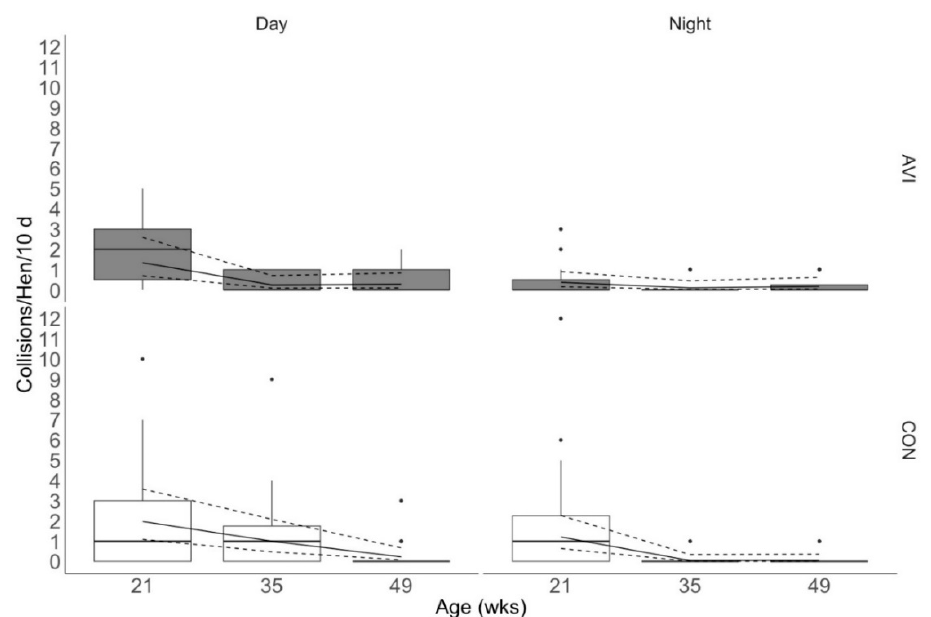
Figure 3. Total collisions >20 G sustained per hen over 10 d at each age during lights on (16 h/d) and lights off (8 h/day) in enriched colony cages (ECC). Hens were reared in either conventional non-enriched cages (CON) or a multi-tiered aviary (AVI) until 19 weeks of age before being moved into ECC. Collisions were with structural objects or conspecifics. Boxes represent the interquartile range, where the black line represents the median, the top of the box represents the 75th quartile, and the bottom of the box represents the 25th quartile. Whiskers represent the minimum and maximum values, while black dots indicate outliers. The solid line overlaying the box plots is the estimated mean values from the generalized linear mixed effects model, and the dashed lines represent the 95% confidence intervals of the estimated means. wks: weeks.